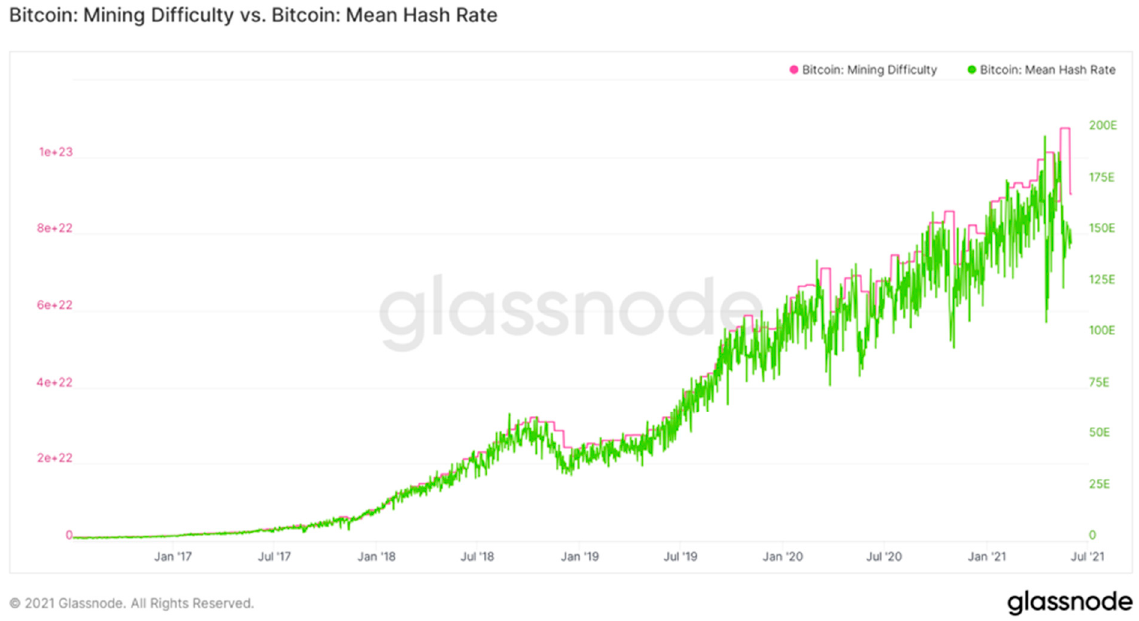
Figure 1. Source: Glassnode (Gans 2021).